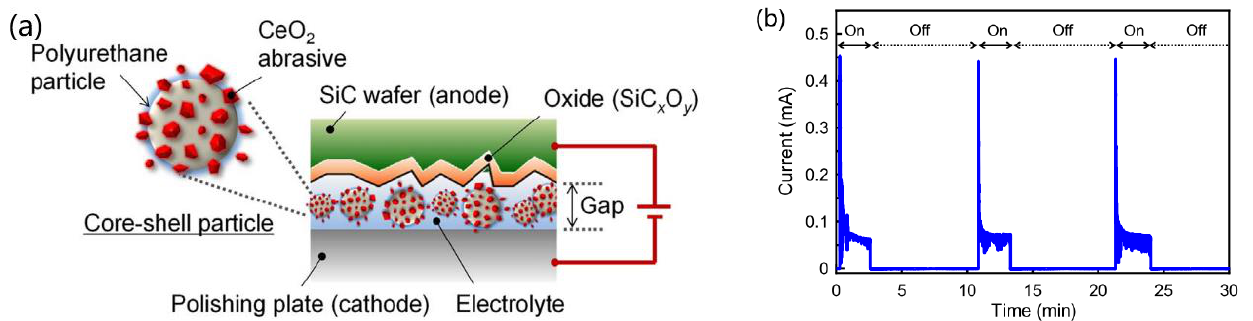
Figure 21. ( a ) Schematic view of the Murata-proposed ECMP method; ( b ) time dependence of anodic current during ECMP with a periodic bias [49] .